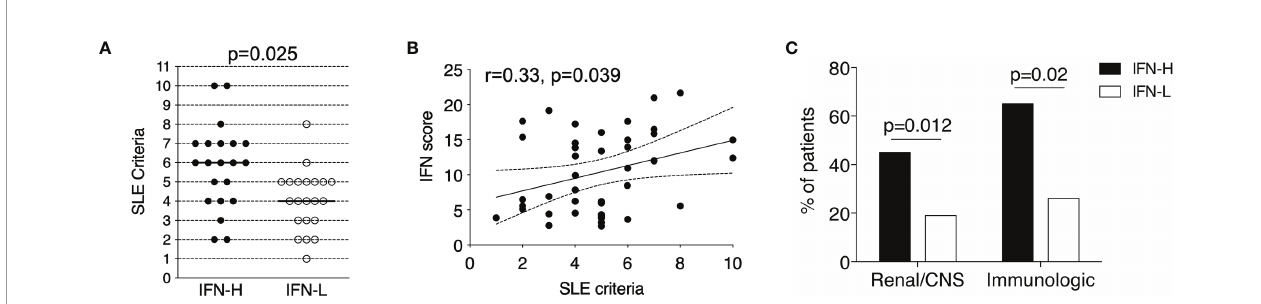
FIGURE 2 | (A-C) IFN signature in SLE patients is associated with more severe clinical manifestations. (A) IFN-H (n=21) patients exhibited signi fi cantly increased SLE criteria as compared to IFN- L (n=21) patients (p=0.025), where IFN-H patients had a median of 6 SLE criteria and IFN-L patients had a median of 4 SLE criteria. Criteria used followed the 1982 American College of Rheumatology SLE revision. P values determined by Mann-Whitney test. (B) IFN score and SLE criteria are signi fi cantly positively associated by Spearman regression analysis (r=0.33, p=0.049). 95% con fi dence interval is indicated by dashed lines. (C) IFN-H patients exhibit signi fi cantly higher percentage of renal (proteinuria and/or biopsy-proven LN) or central nervous system (CNS=central nervous system as de fi ned as seizure, psychosis, and/or cerebritis), p=0.012; and immunologic (immunologic as de fi ned as dsDNA+ or Sm+) p=0.02, manifestations as compared to IFN-L patients. P values determined by